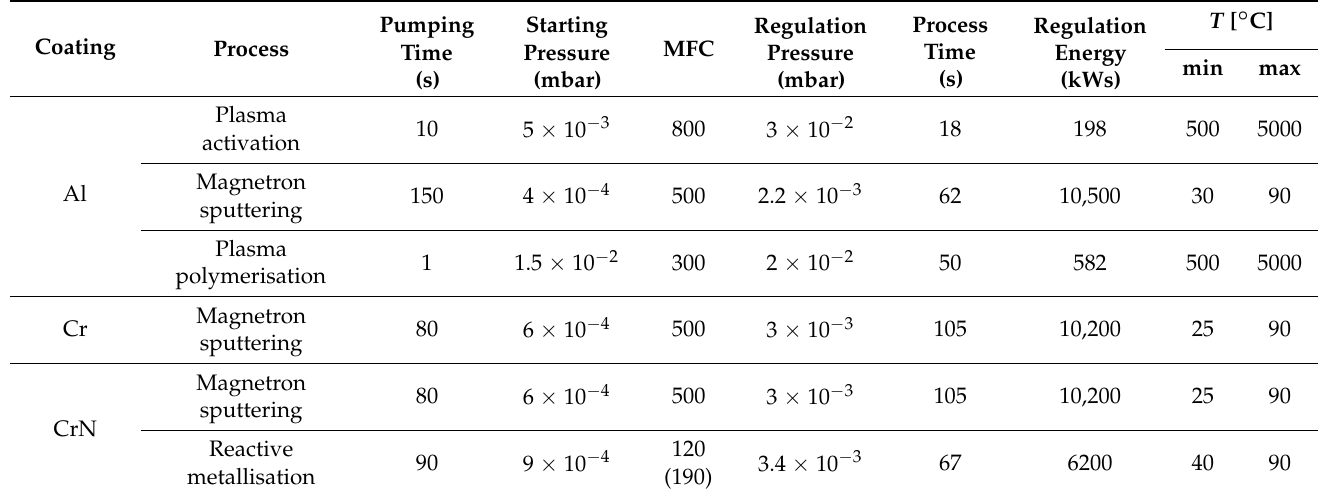
Table 1. Process parameters of the analysed